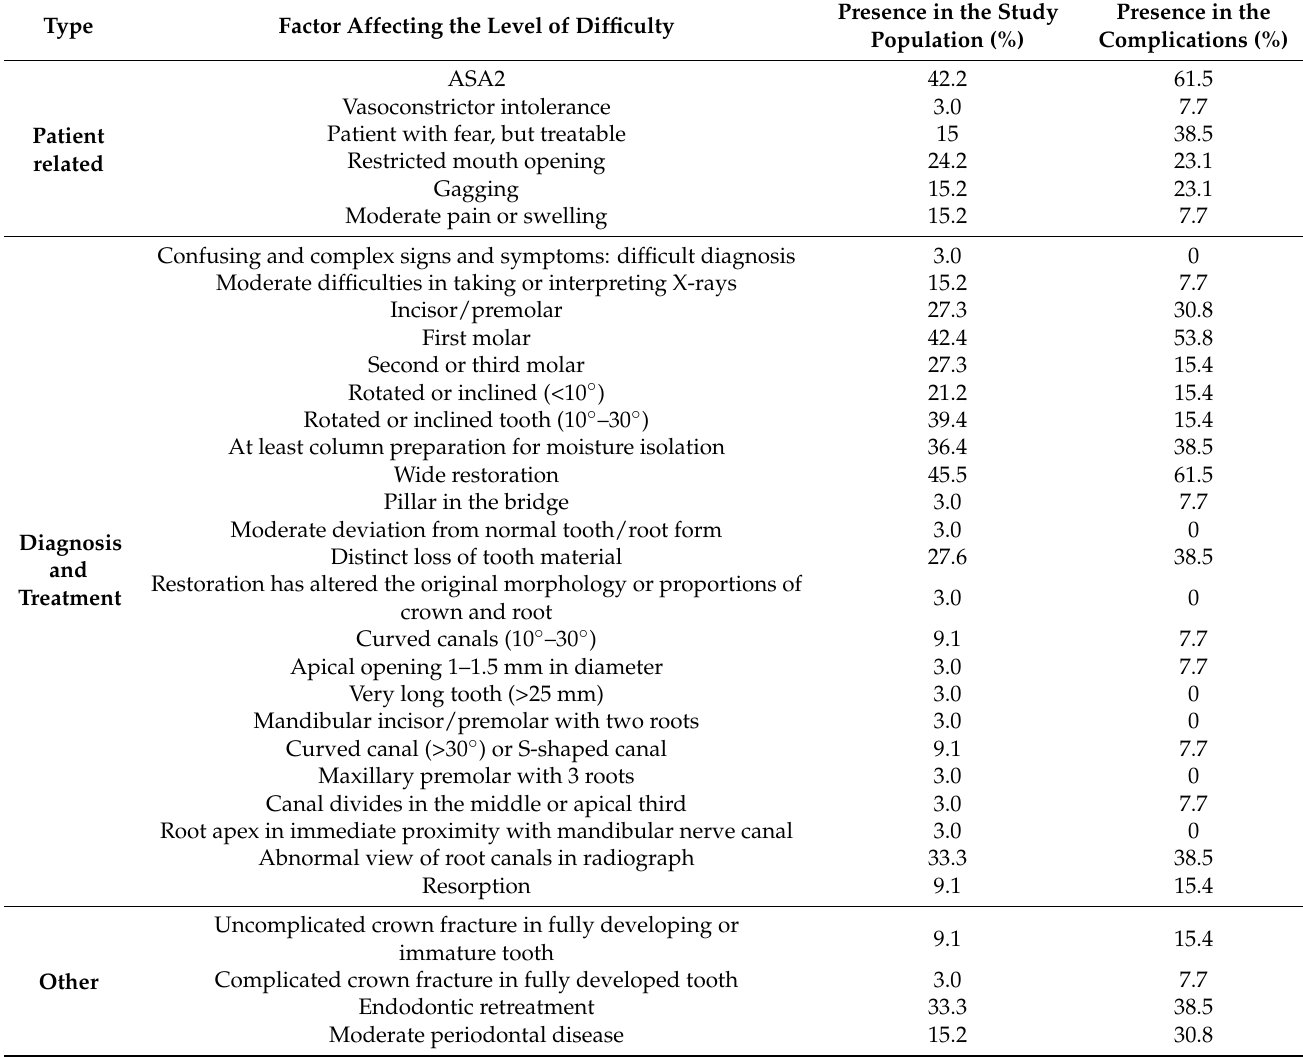
Table 2. Presence of the factors affecting root canal treatment in the research population and presence of those factors in the complications during the